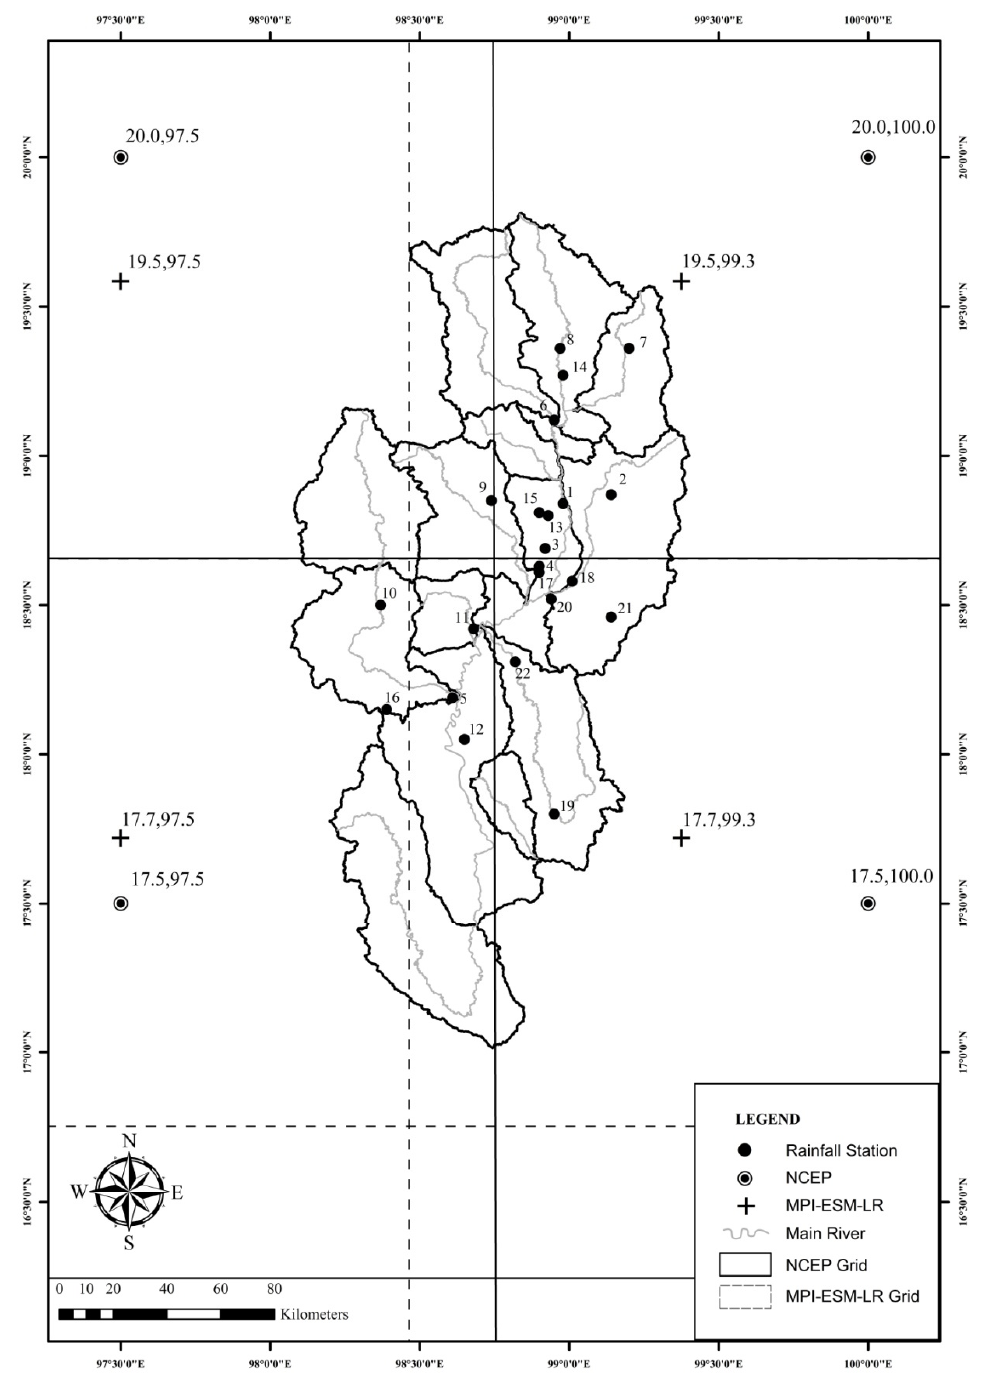
Figure 1. The location of the upper Ping river basin and GCM grids.